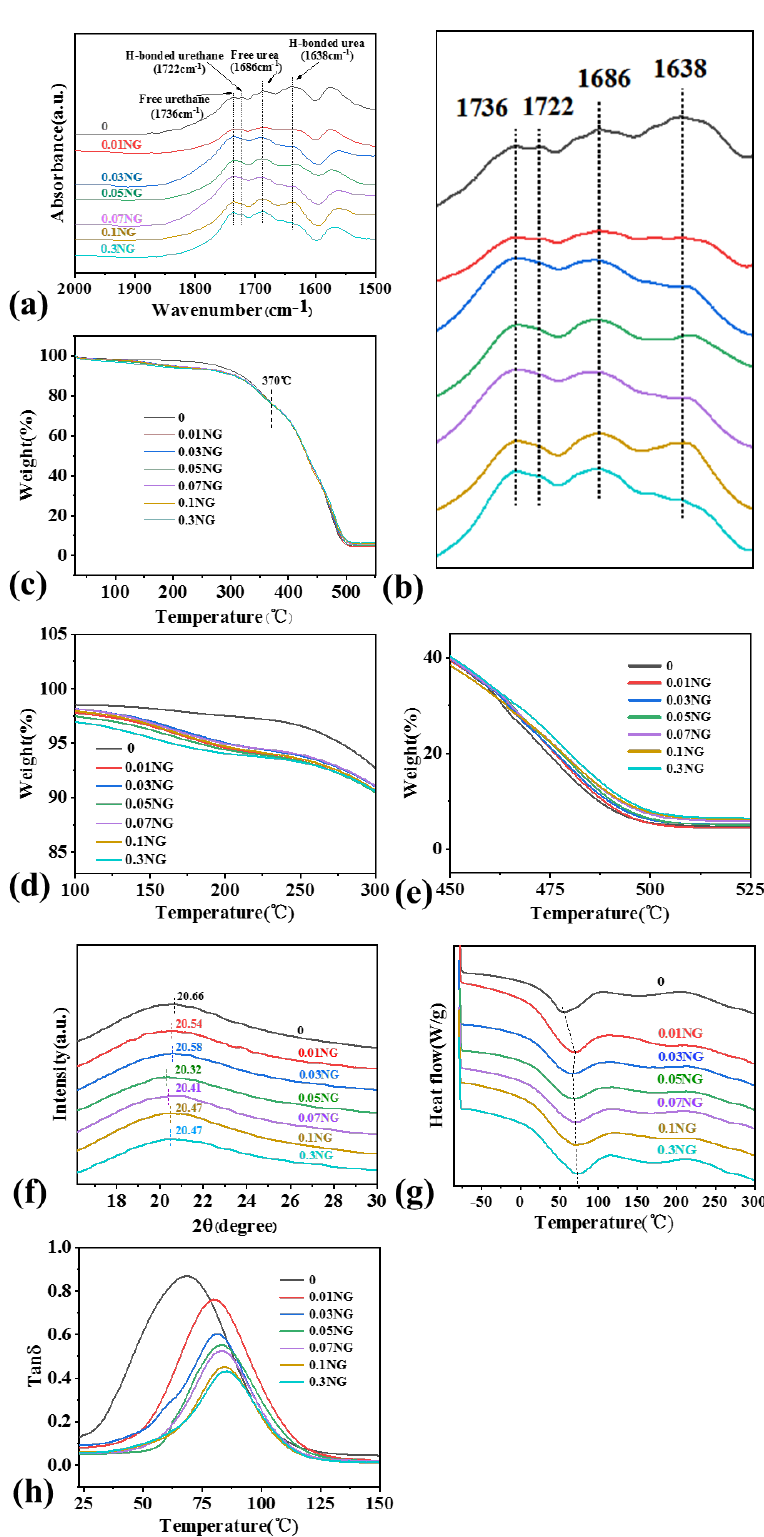
Figure 7. ( a ) FTIR spectra, ( b ) enlarged images of curves of FTIR spectra; ( c – e ) TGA measurements: ( c ) temperature range of 30 – 525 °C, enlarged temperature range of ( d ) 100 – 300 °C and ( e ) 450 – 525 °C; ( f ) XRD patterns; ( g ) differential scanning calorimetry (DSC); ( h ) DSR of WPU and its composites with different NGS content.